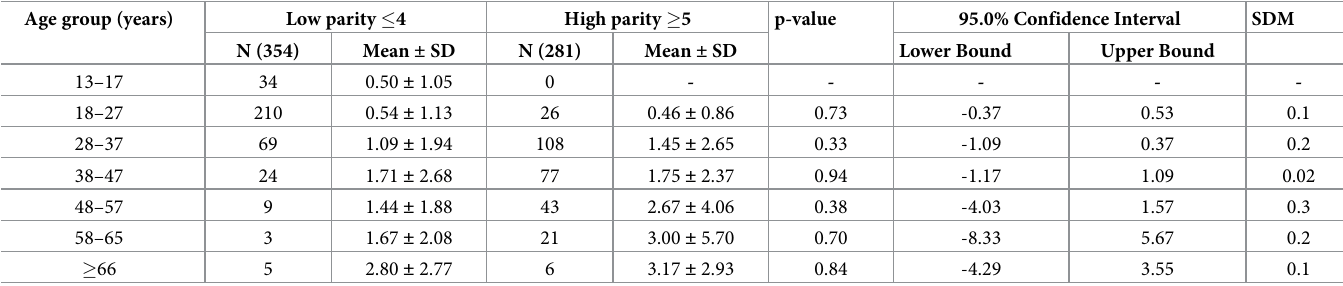
Table 3. Mean DMFT scores by parity